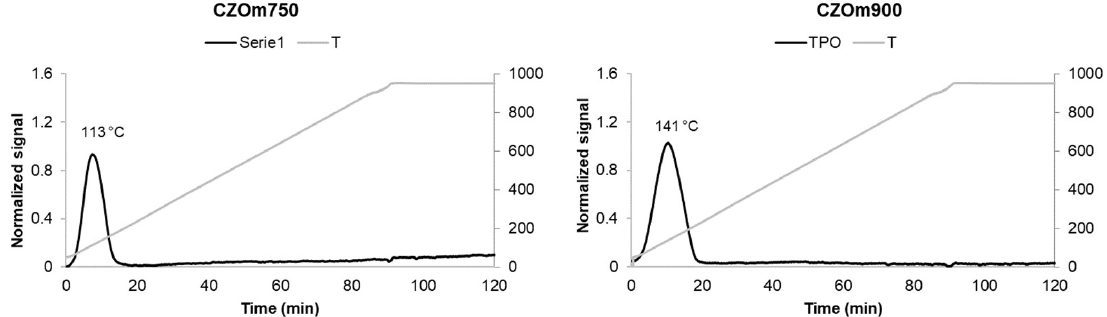
Figure 3. Temperature-programmed oxidation of CZOm750 and CZOm900 samples.